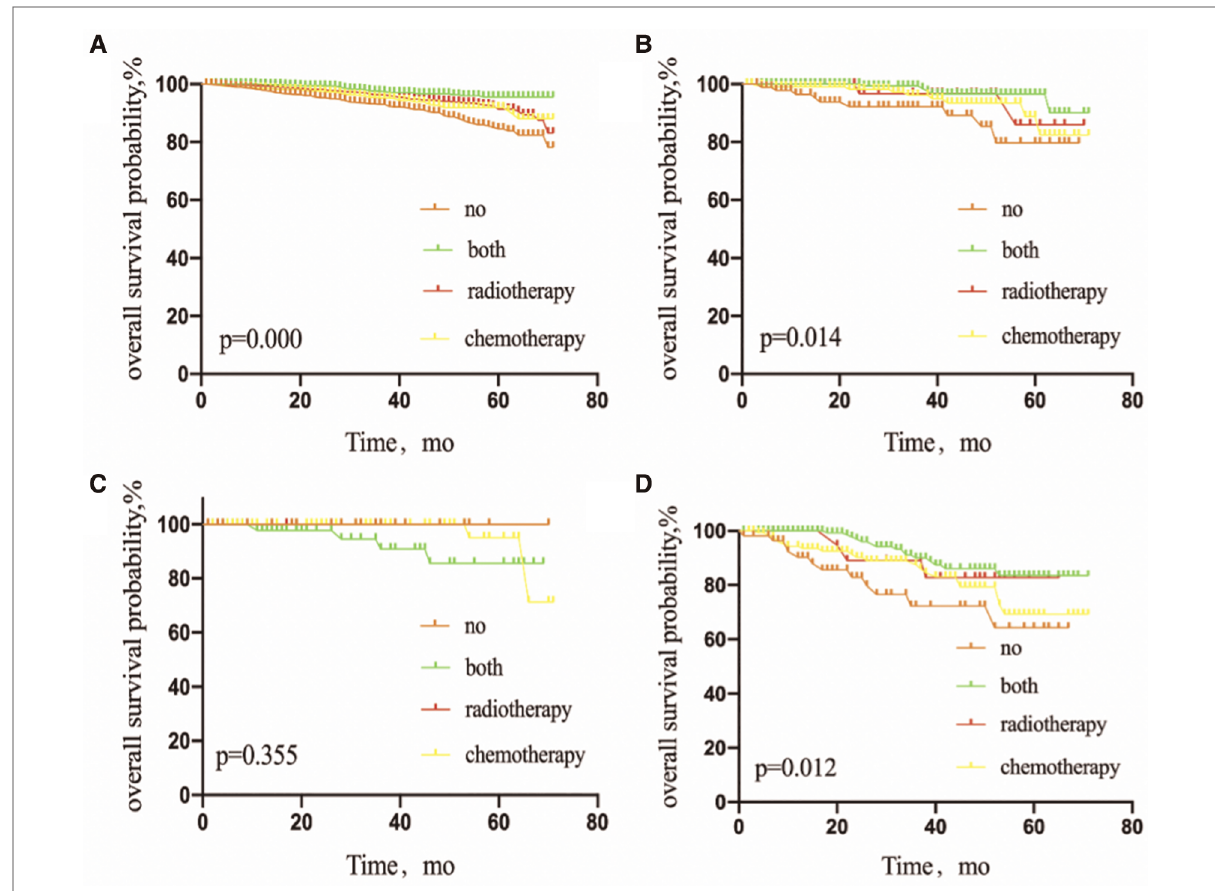
FIGURE 4 Kaplan – Meier curves depicting overall survival between treatment arms in patients with breast cancer luminal A subtype ( A ), luminal B subtype ( B ), HER2 overexpression subtype ( C ), or triple-negative subtype ( D ) with 1 or 2 sentinel lymph node micrometastases treated with sentinel lymph node biopsy alone. NO patients treated with no adjuvant therapies; BOTH patients treated with both adjuvant chemotherapy and radiotherapy; RADIOTHERAPY patients treated with adjuvant radiotherapy; CHEMOTHERAPY patients treated with adjuvant